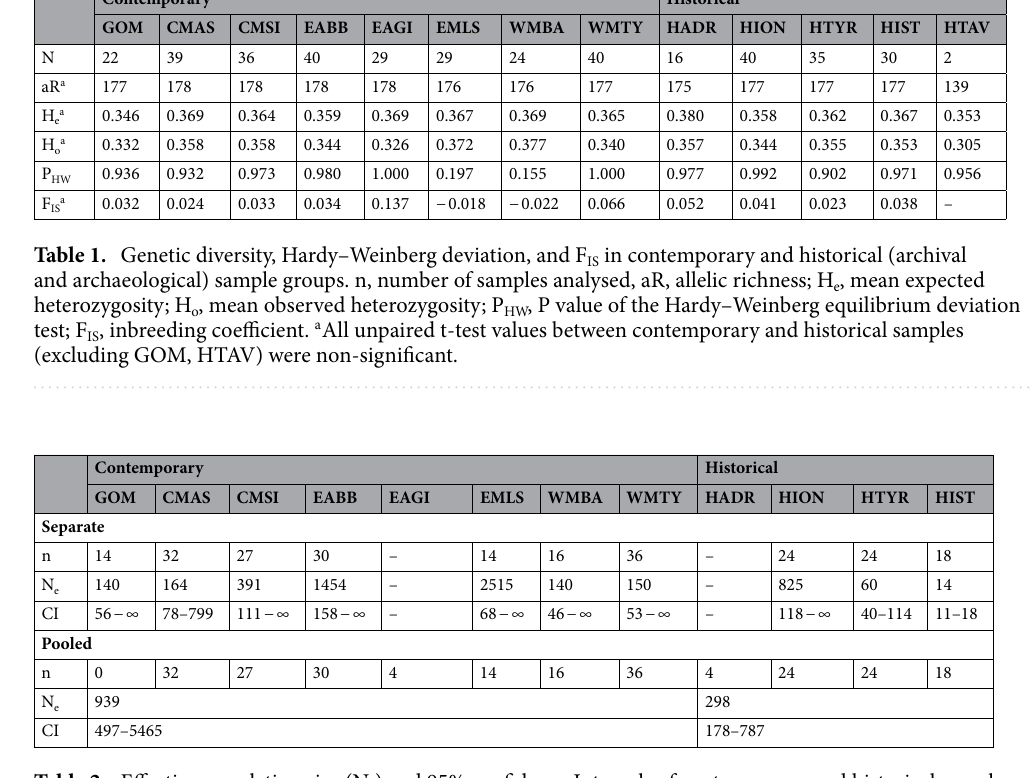
Table 2. Effective population size (N e ) and 95% confidence Intervals of contemporary and historical sample groups for samples (n) consistently scored across all 89 neutral loci analysed herein, under two approaches, where separate estimates were made for each sample group and for contemporary and historical